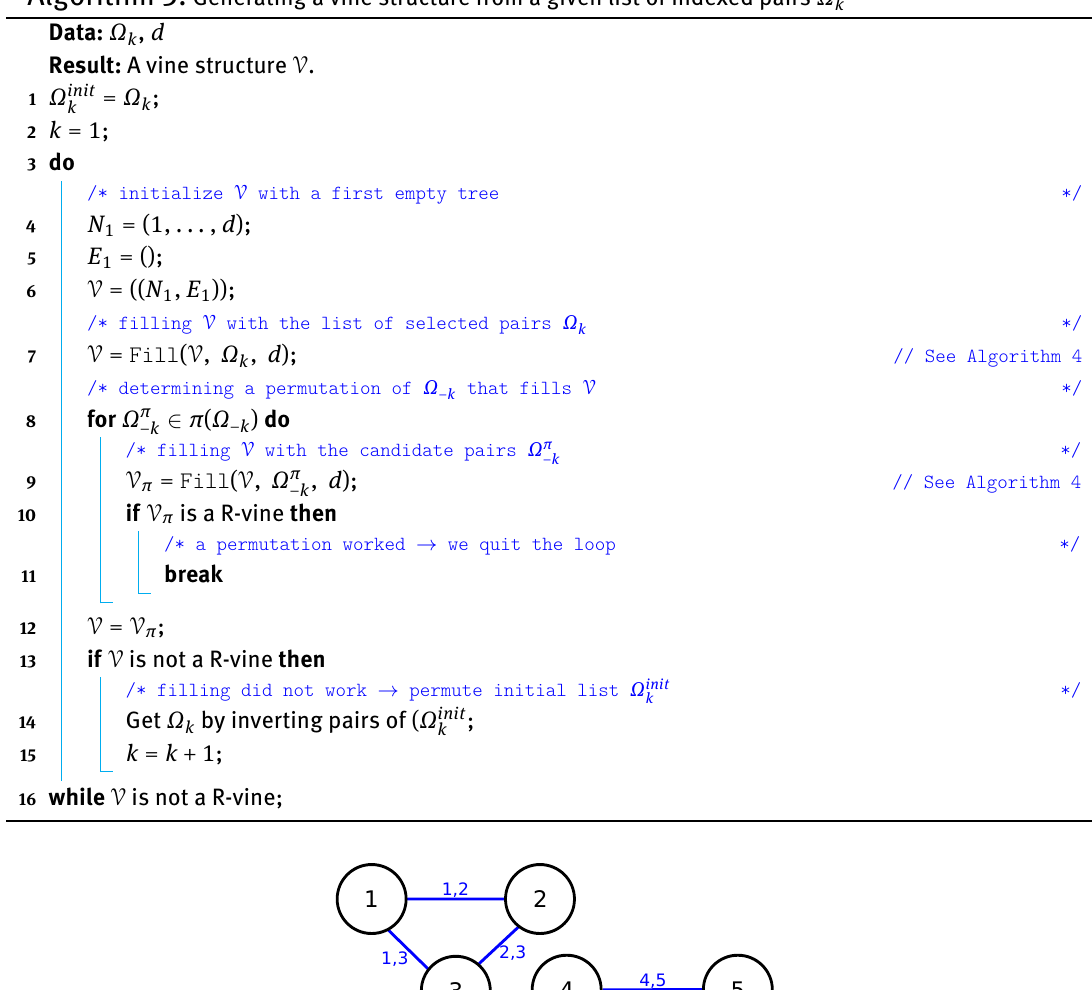
Algorithm 3: Generating a vine structure from a given list of indexed pairs Ω Data: Ω k , d